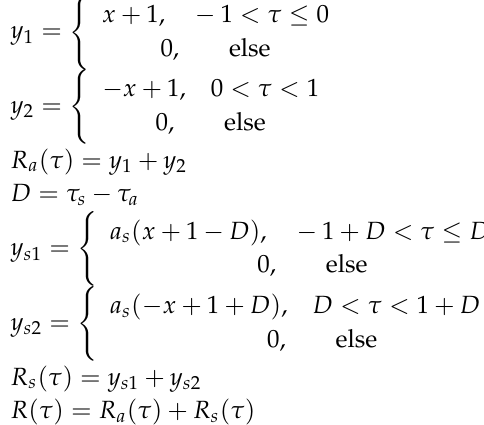
Figure 1. Illustration of a spoofing scenario.